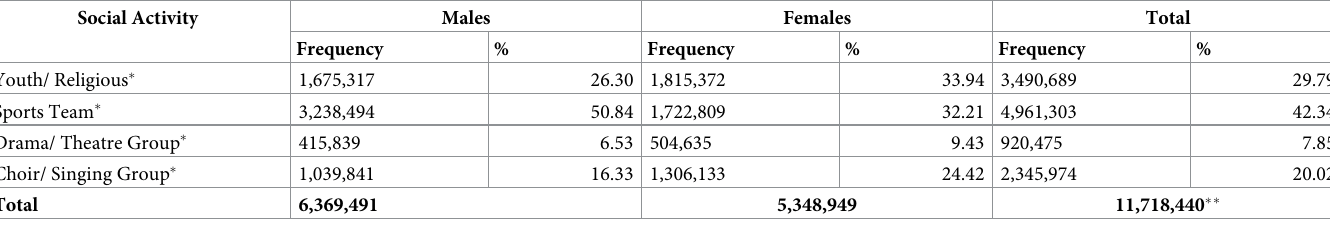
Table 1. Weighted distribution of social activity participation among youth in South Africa.